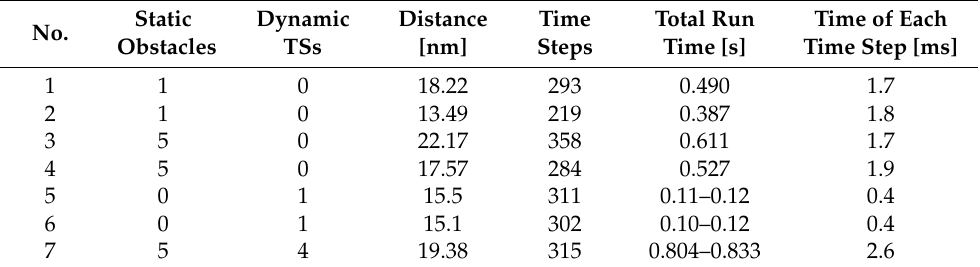
Table 10. Initial inputs and simulation results for U-shaped